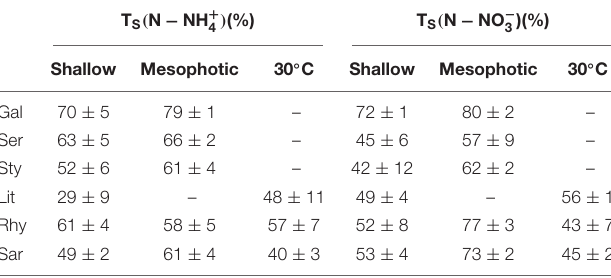
TABLE 1 | Translocation percentages (T S ) of organic nitrogen compounds derived from the assimilation of dissolved inorganic nitrogen (either NH 4 + or NO 3 − ) by the algal symbionts in hard (Gal = Galaxea fascicularis , Ser = Seriatopora hystrix , Sty = Stylophora pistillata ) and soft coral (Lit = Litophyton arboreum , Rhy = Rhytisma fulvum fulvum , Sar = Sarcophyton sp.) holobionts from shallow and mesophotic